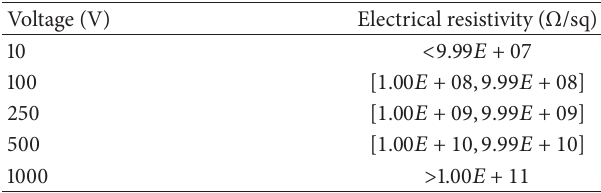
Table 1: Applied voltage of electrical resistivity meter.